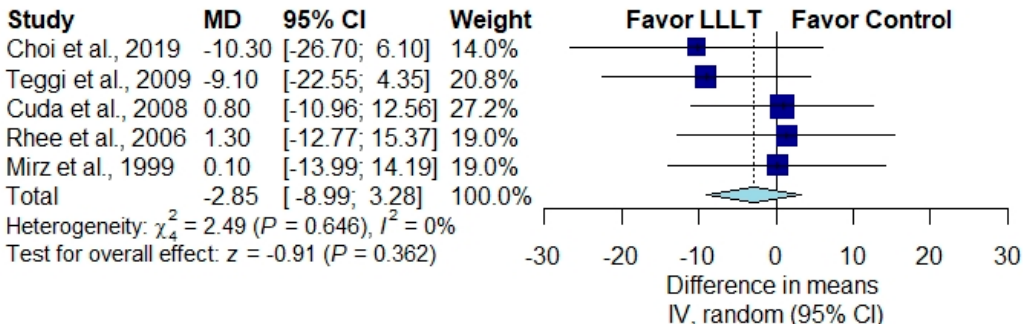
Figure 2. Overall e ff ect of low-level laser therapy (LLLT) as measured by the THI score Figure 2. Overall effect of low ‐ level laser therapy (LLLT) as measured by the THI score [1,28–31].